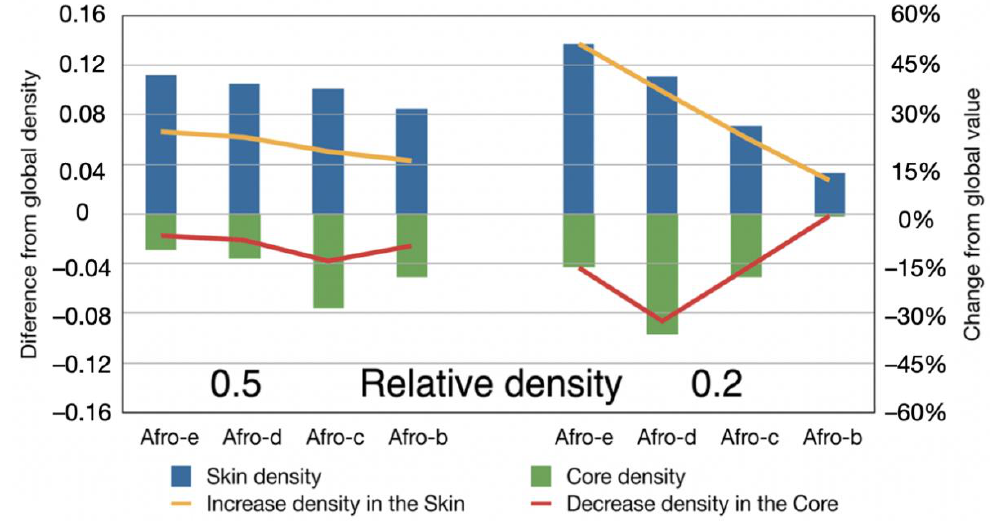
Figure 12. The yellow line shows the increase in density in the ‘skin’, and the red line shows the decrease of density in the ‘core’.